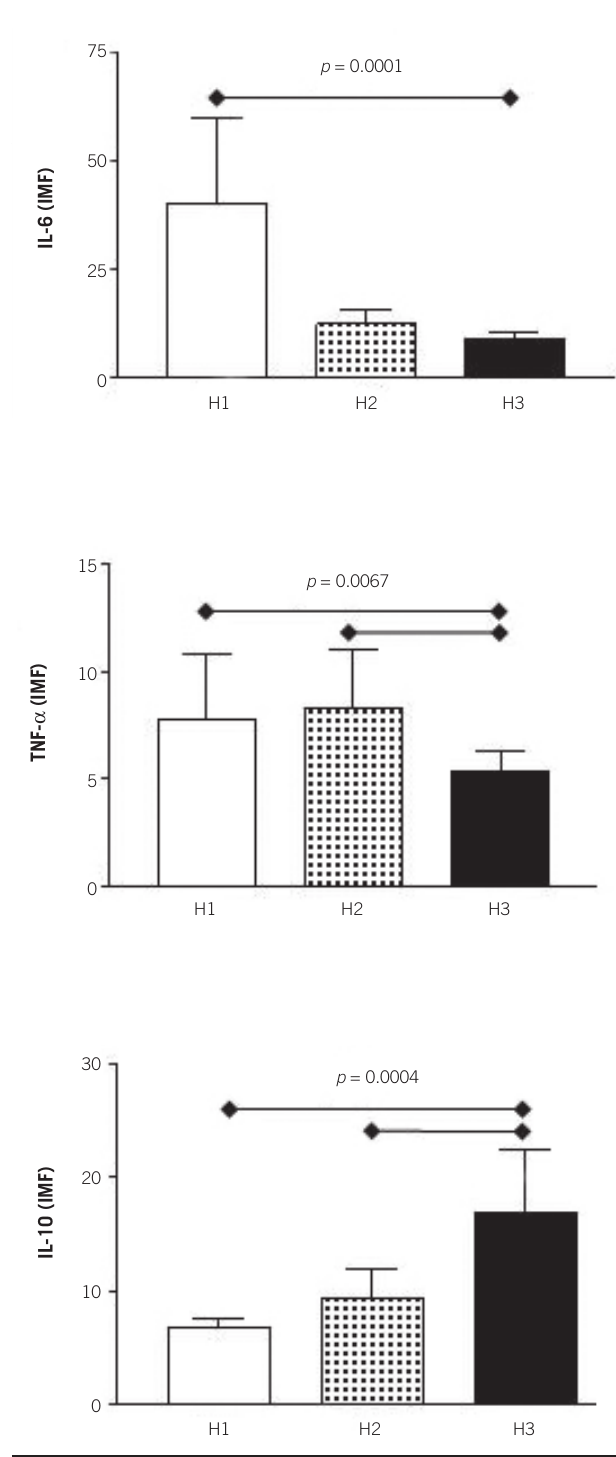
figuRE 2 − Plasma levels of inflammatory (IL-6 and TNF- α ) and regulating (IL-10) cytokines in the groups of kidney transplant patients (H1, H2, and H3) according to the number of HLA matches H1: fewer than three matches; H2: three matches; H3: more than three matches; MFI: mean fluorescence intensity. Data presented as